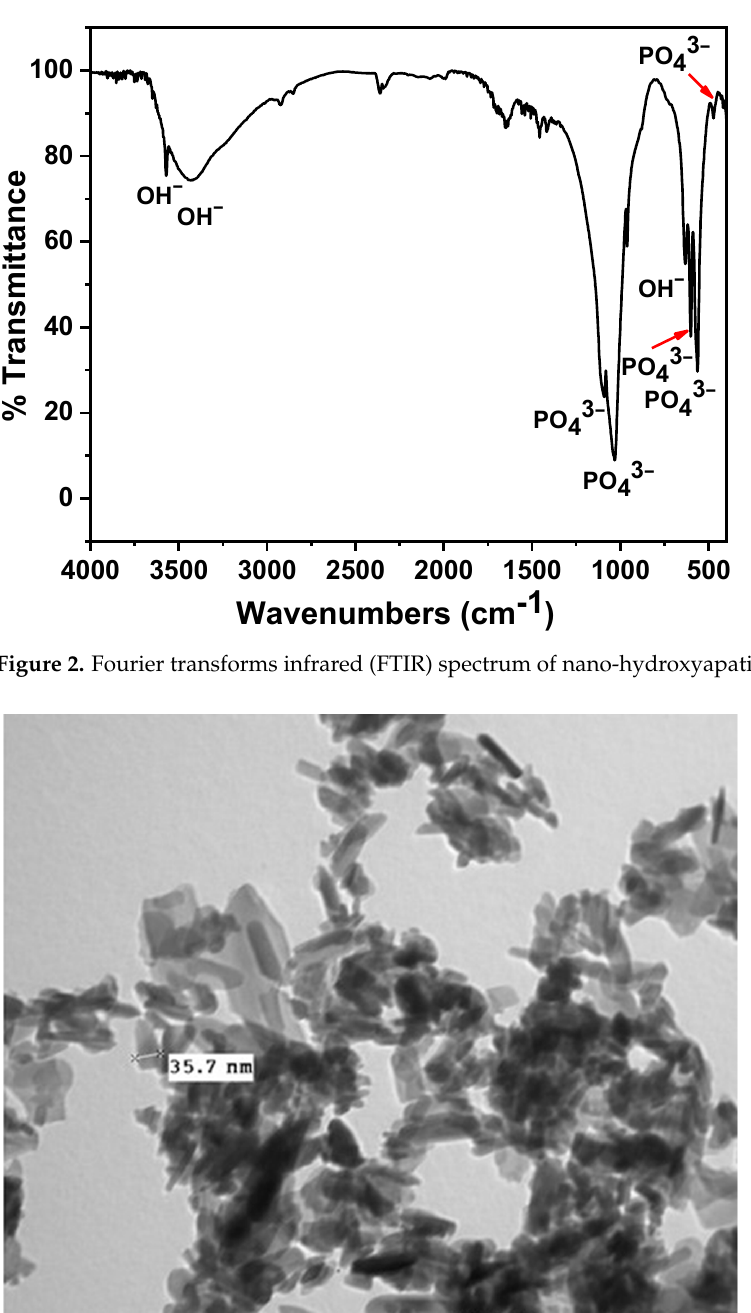
Figure 1. X-ray diffraction (XRD) pattern of nano-hydroxyapatite (n-HAP).